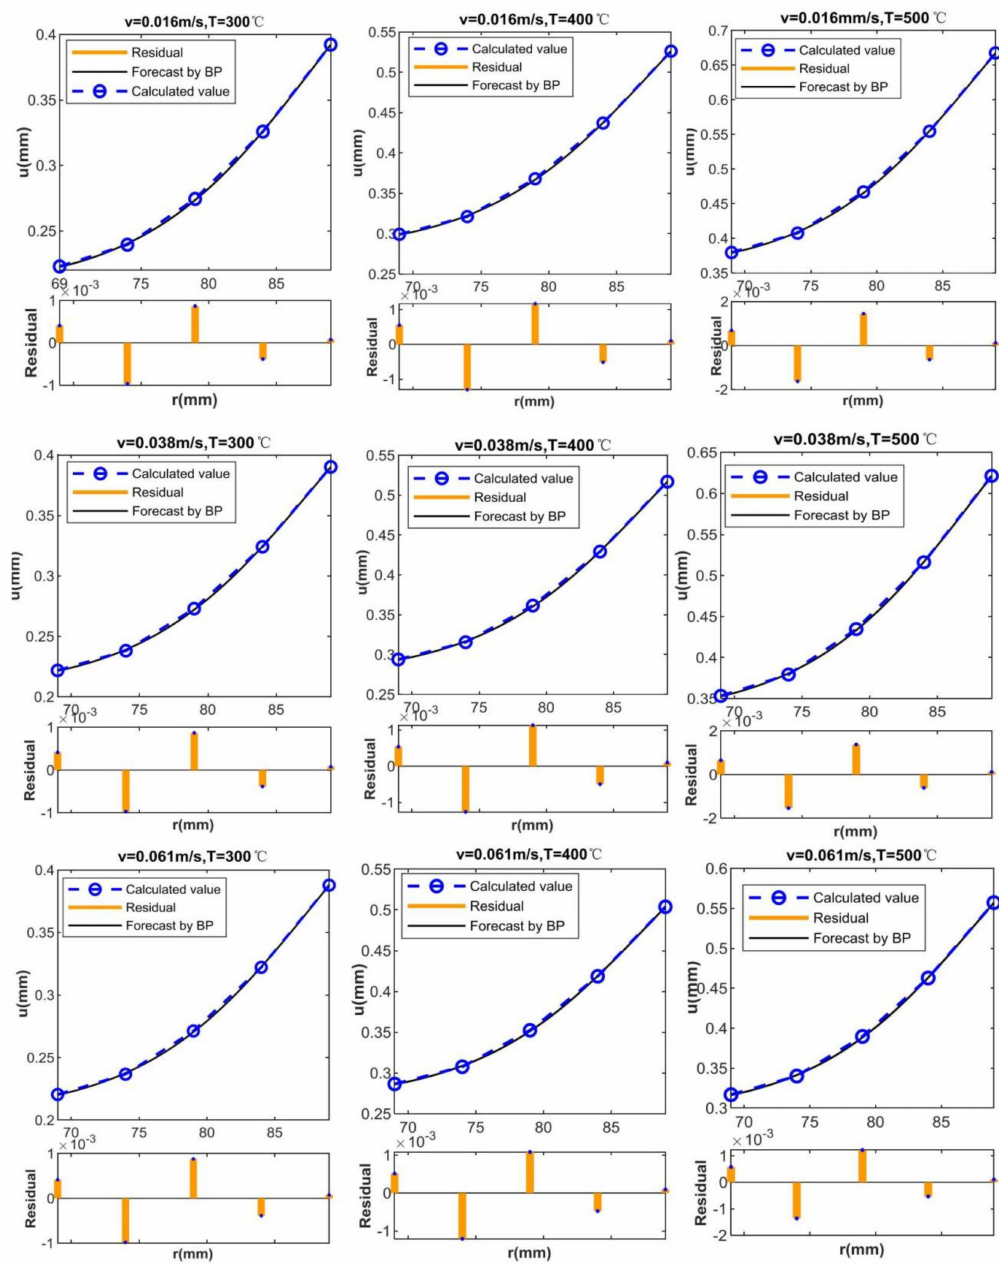
Figure 9. Sectional radial deformation prediction model and